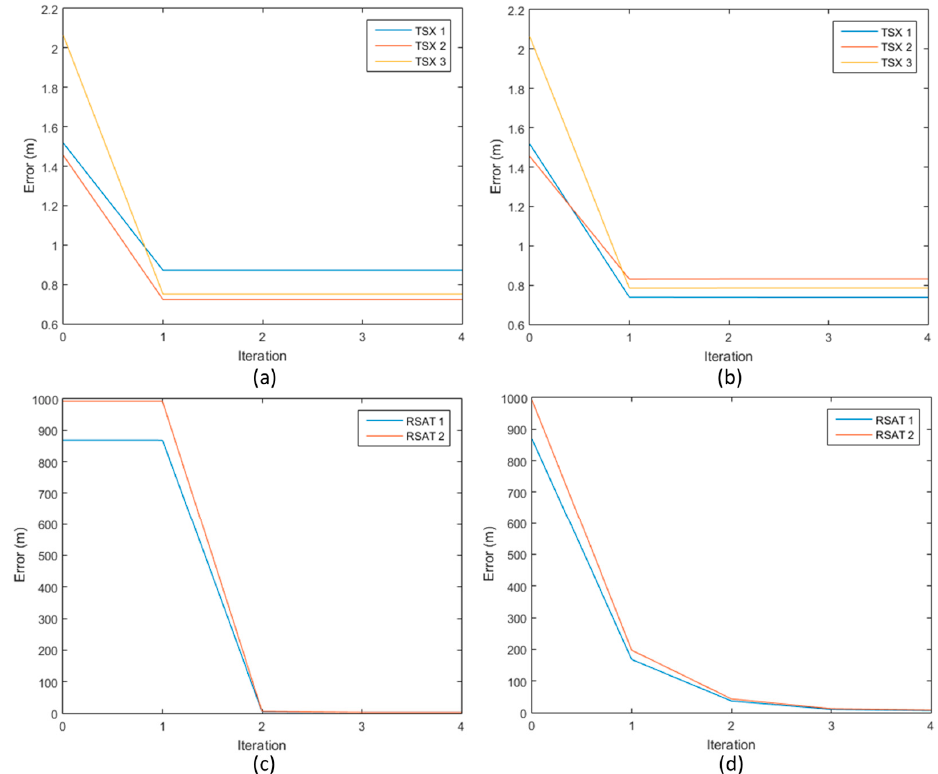
Figure 3. Convergence of parameters in iterative geometric correction process: ( a ) geometric correction of TerraSAR-X based on orbit parameters; ( b ) geometric correction of TerraSAR-X based on time-offset parameters; ( c ) geometric correction of Radarsat-1 based on orbit parameters; ( d ) geometric correction of Radarsat-1 based on time-offset parameters. Table 3. Results of geometric correction based on orbit parameters and time-offset parameters.